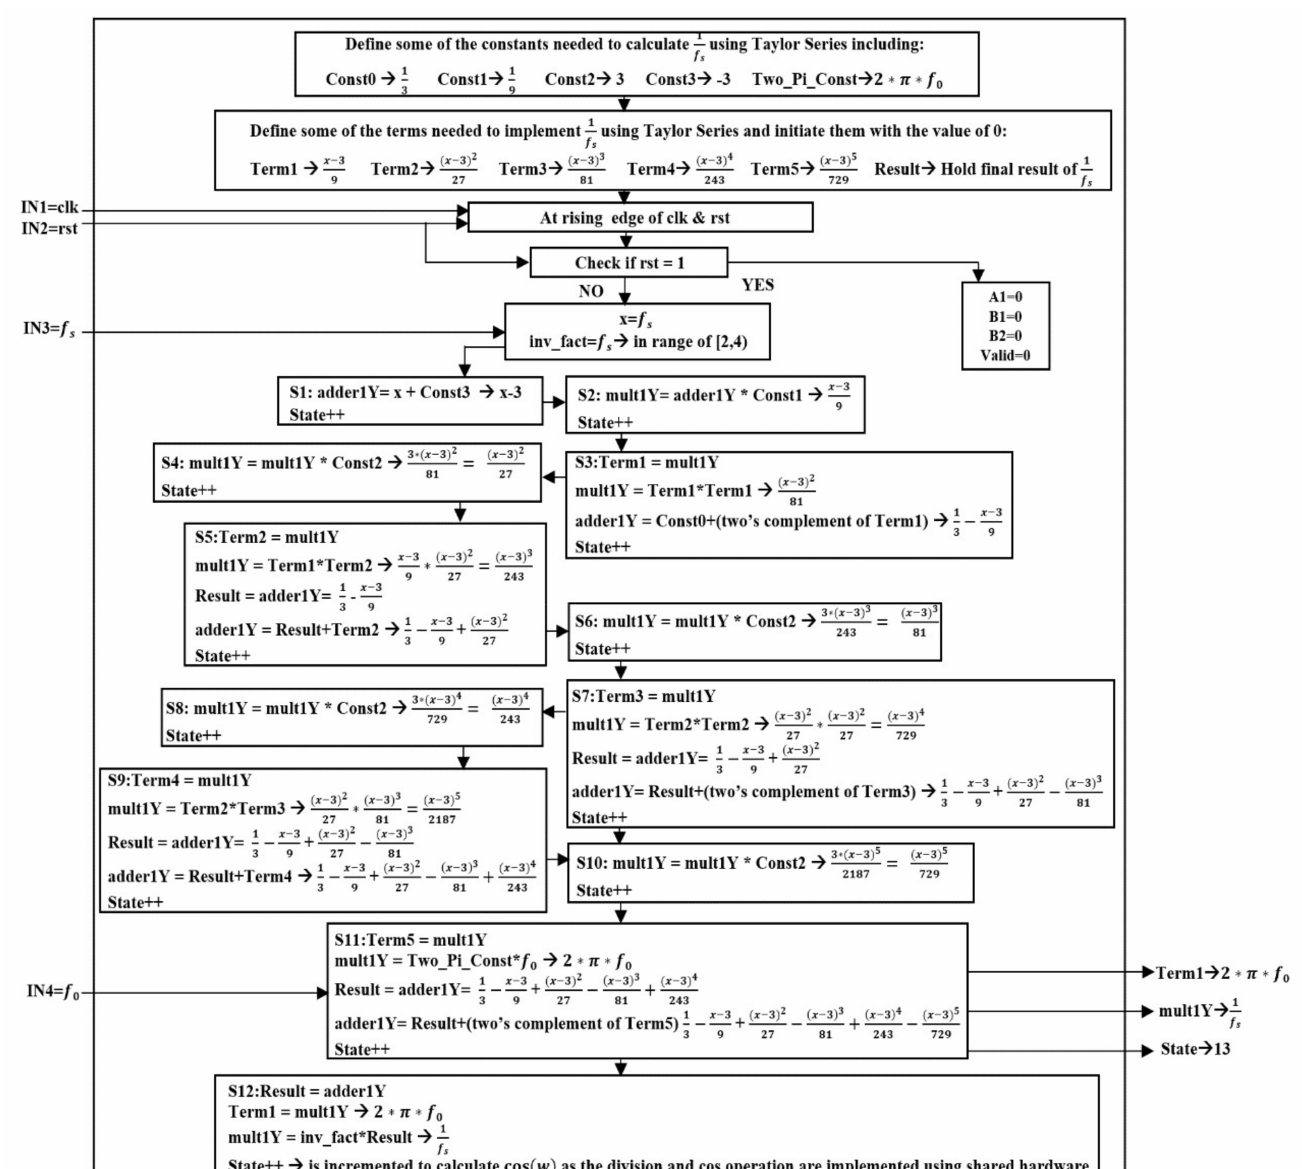
Figure 10. The shared hardware of the division arithmetic unit that is used to implement 1